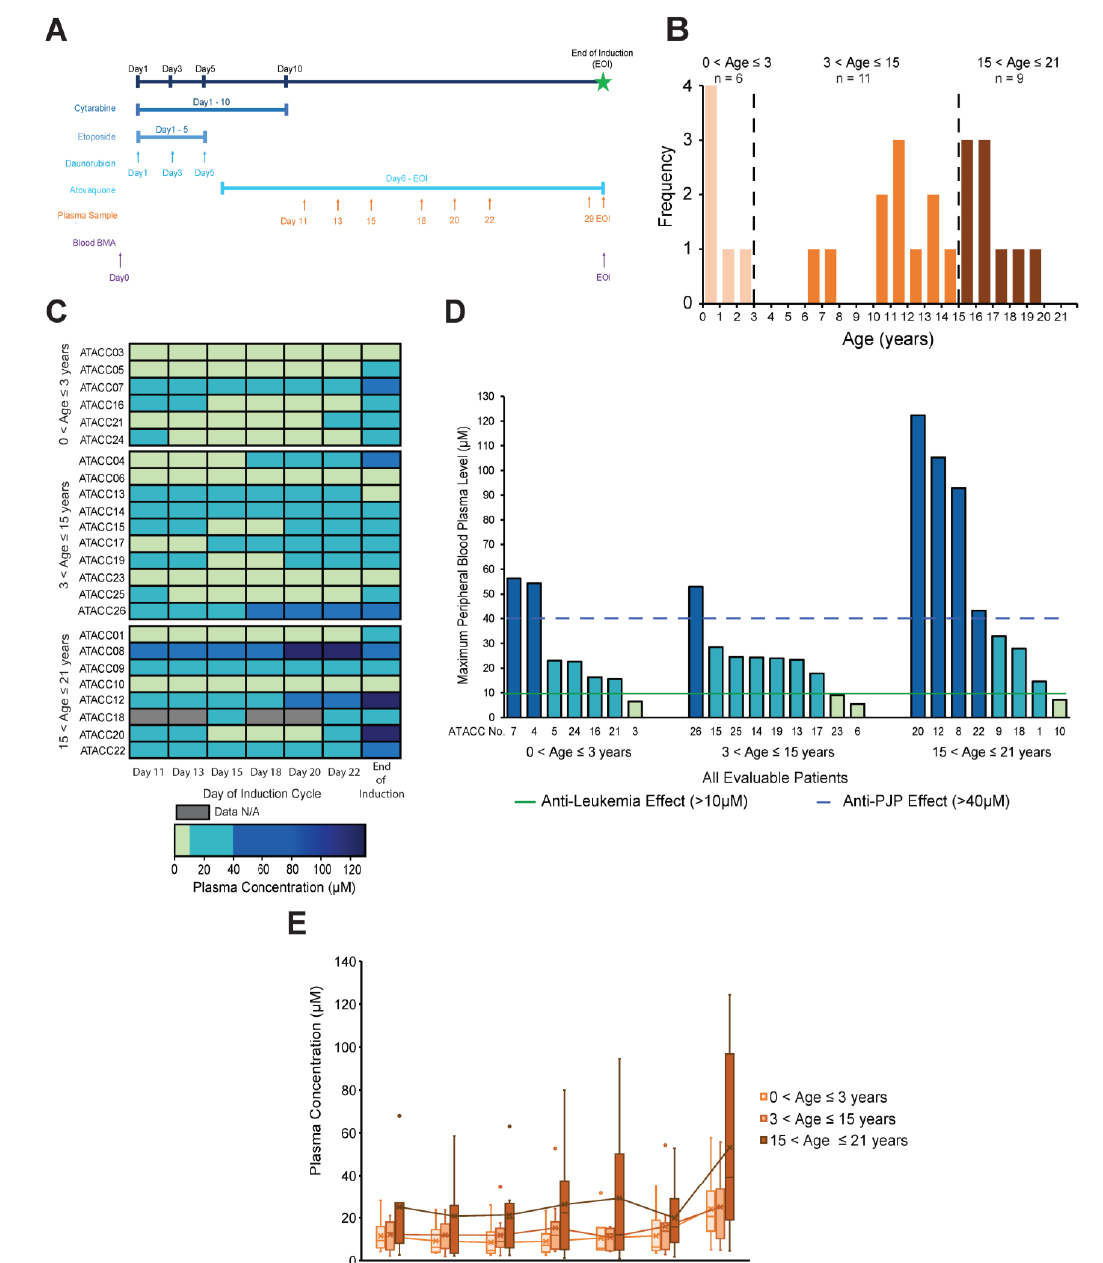
Figure 1. Plasma concentrations of atovaquone during treatment. ( A ) Schema of Induction 1 treat- ment period including administration of chemotherapy and sampling times. ( B ) Age distribution of patients included in the clinical trial. ( C ) Overview of plasma concentrations ( µ M) in the peripheral blood for each of the 24 patients (grouped by age range based on ( B ) after starting atovaquone administration. Concentrations were measured on days 11, 13, 15, 18, 20, 22, and at the end of induction (EOI). ( D ) Maximum peripheral blood plasma concentrations ( µ M) achieved for each patient. ( E ) Whisker plot showing the ranges and averages atovaquone peripheral blood plasma concentrations achieved within each age group. X indicates mean concentration; top and bottom vertical lines indicate maximum and minimum values, respectively; top horizontal line of the box indicates 3rd quartile, bottom horizontal line indicates 1st